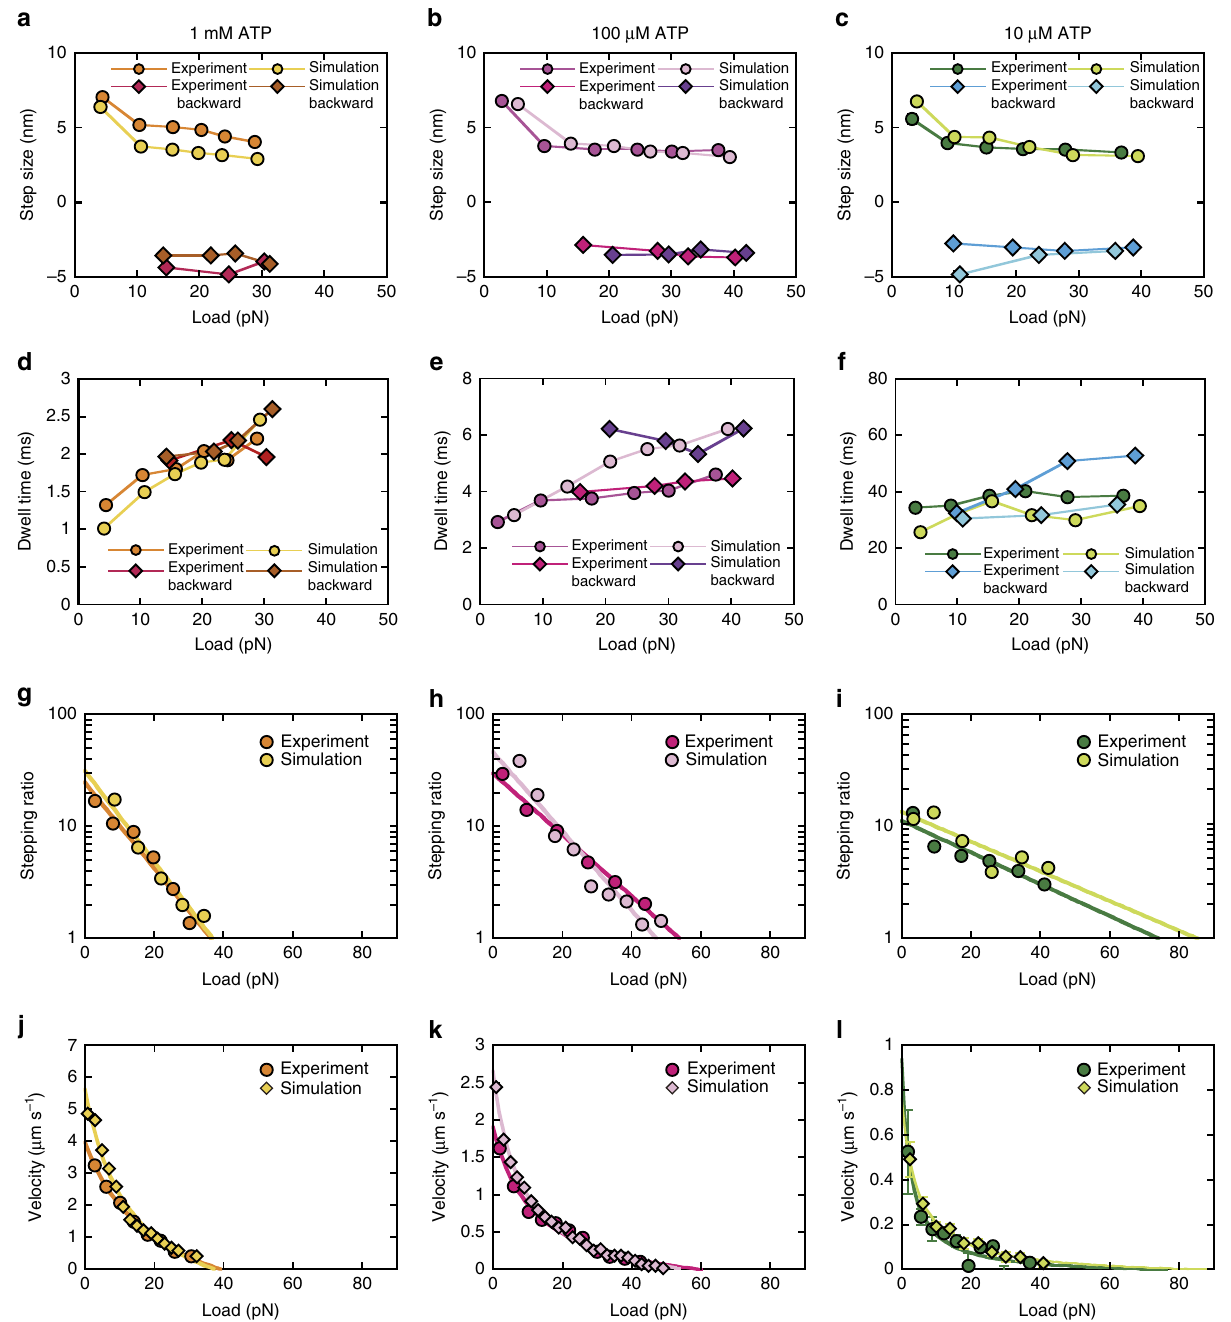
Figure 3 | Step properties as a function of load at different ATP concentrations. ( a – c ) Mean forward and backward step sizes as a function of load obtained from experiments and the simulation model at 1mM (experiment: n ¼ 181 and 84 for forward and backward steps, respectively, from 3 beads; simulation: n ¼ 649 and 220 for forward and backward steps, respectively, from 12 trials) in a , 100 m M in ( n ¼ 863 and 205 for forward and backward steps, respectively, from 3 beads; simulation: n ¼ 668 and 239 for forward and backward steps, respectively, from 8 trials) in b and 10 m M ATP ( n ¼ 335 and 89 for forward and backward steps, respectively, from 4 beads; simulation: n ¼ 368 and 114 for forward and backward steps, respectively, from 24 trials) in c . ( d – f ) Mean dwell times obtained from experiments and the simulation model at 1mM, 100 m M and 10 m M ATP in d – f , respectively. The abscissas of the fitting functions provided estimates of the stall forces: 36, 54 and 74pN at 1mM, 100 m M and 10 m M ATP, respectively, in experiment; 37, 47 and 85pN at 1mM, 100 m M and 10 m M ATP, respectively, in simulation. ( g – i ) Stepping ratio calculated from experiments and the simulation model at 1mM, 100 m M and 10 m M ATP in g - i , respectively. The natural logarithms of the stepping ratio were plotted against the load and fitted to linear functions; the abscissa represents the stall force. ( j – l ) Force–velocity (FV) relationships obtained from experiments and the simulation model at 1mM (experiment: 7 beads; simulation 12 trials), 100 m M (experiment: 10 beads; simulation 8 trials) and 10 m M ATP (experiment: 6 beads; simulation 24 trials) in j – l , respectively. Each data set was fitted with Hill’s FVequation, ( F þ a )( V þ b ) ¼ ( F 0 þ a ) b , where F 0 , a and b are stall force and fitting parameters, respectively. The abscissas of the fitting functions provided estimates of the stall forces: 39, 59 and 73pN at 1mM, 100 m M and 10 m M ATP, respectively, in experiment; 37, 56 and 86pN, respectively, in simulation. Error bars represent s.e.m., but most of them are hidden behind symbols.